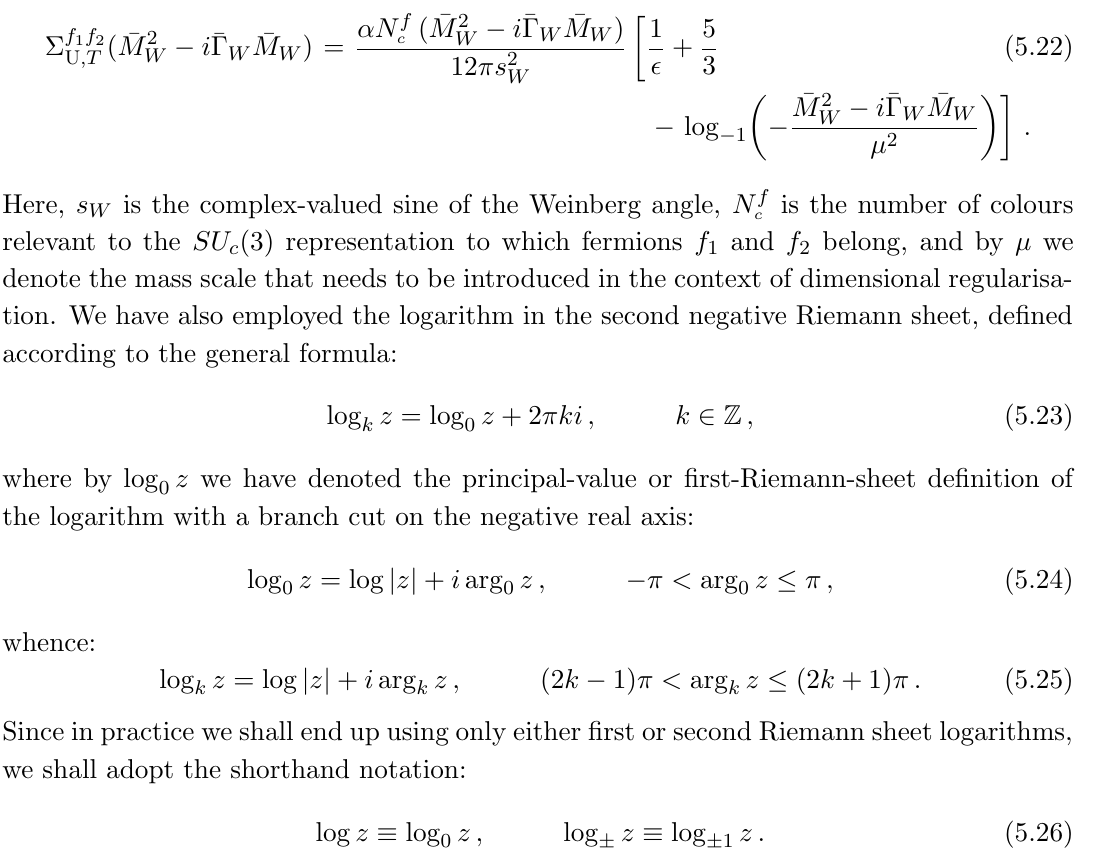
(see eq. (5.22)) and to (cid:6) (cid:13)W U ;T